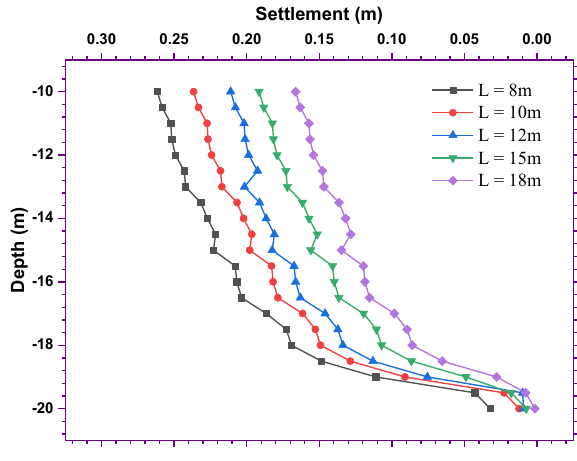
Figure 6: Effect of stone column length (L) on vertical